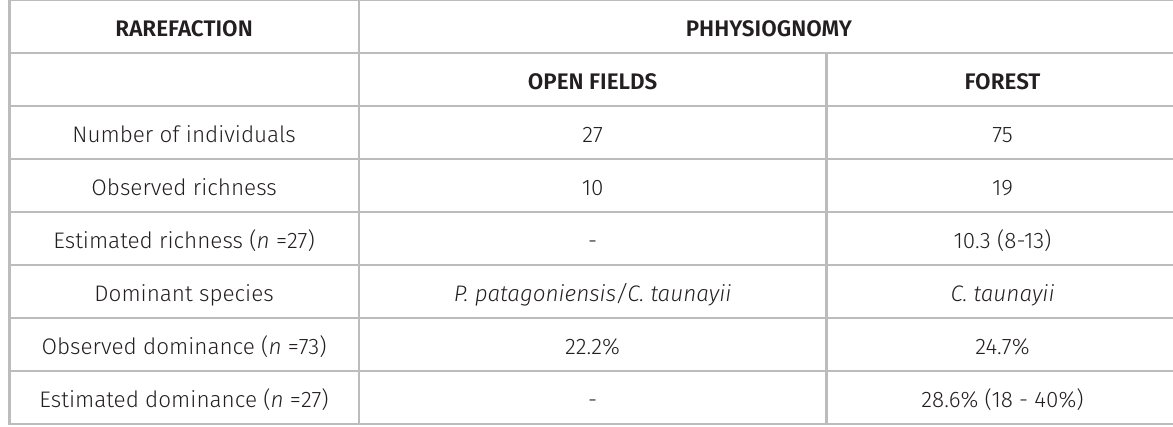
Table II. Diversity of squamate reptiles distributed in the studied physiognomies (open fields and forest) in Curucutu